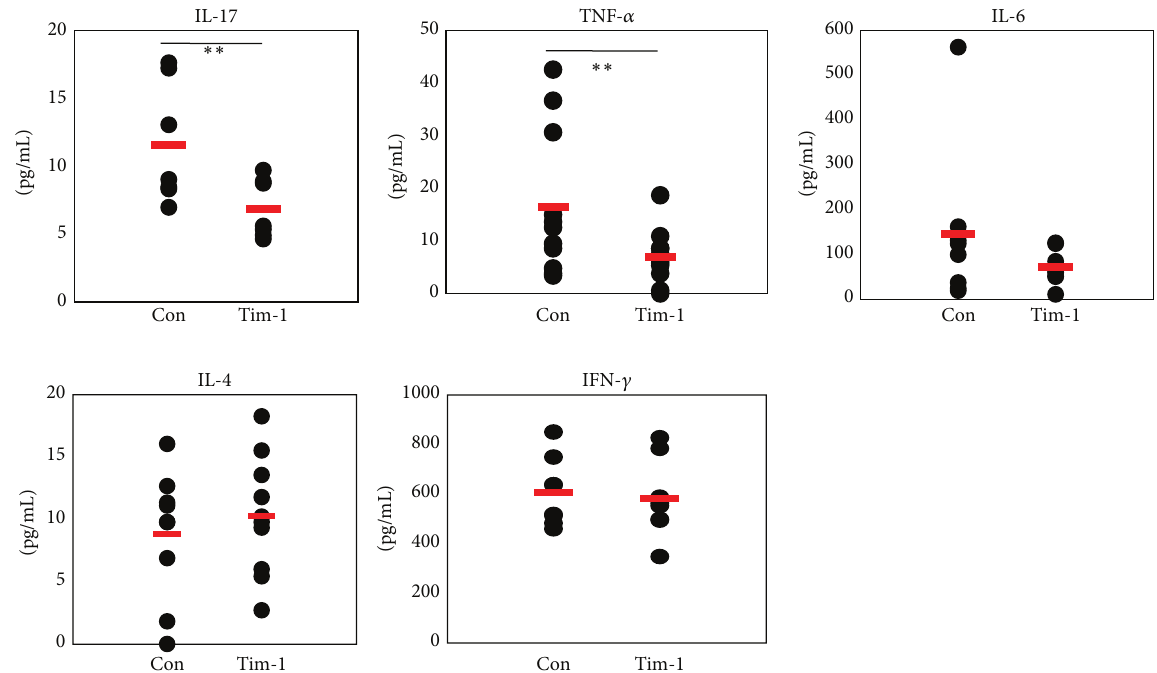
Figure 6: Administration of the Tim-1 vector decreased proinflammatory cytokines in Behc¸et’s disease (BD) mice. Serum was isolated from blood at 2 weeks after the first injection of the Tim-1 vector. The levels of interleukin (IL)-17, tumor necrosis factor (TNF)- 𝛼 , IL-6, interferon (IFN)- 𝛾 , and IL-4 were analyzed in the sera of Tim-1 and control vector injected BD mice by ELISA ( 𝑛 = 7 ∼ 11) ( ∗∗ 𝑃 < 0.05 ). Con: control vector injection to BD mice, Tim-1: Tim-1 vector injection to BD mice.